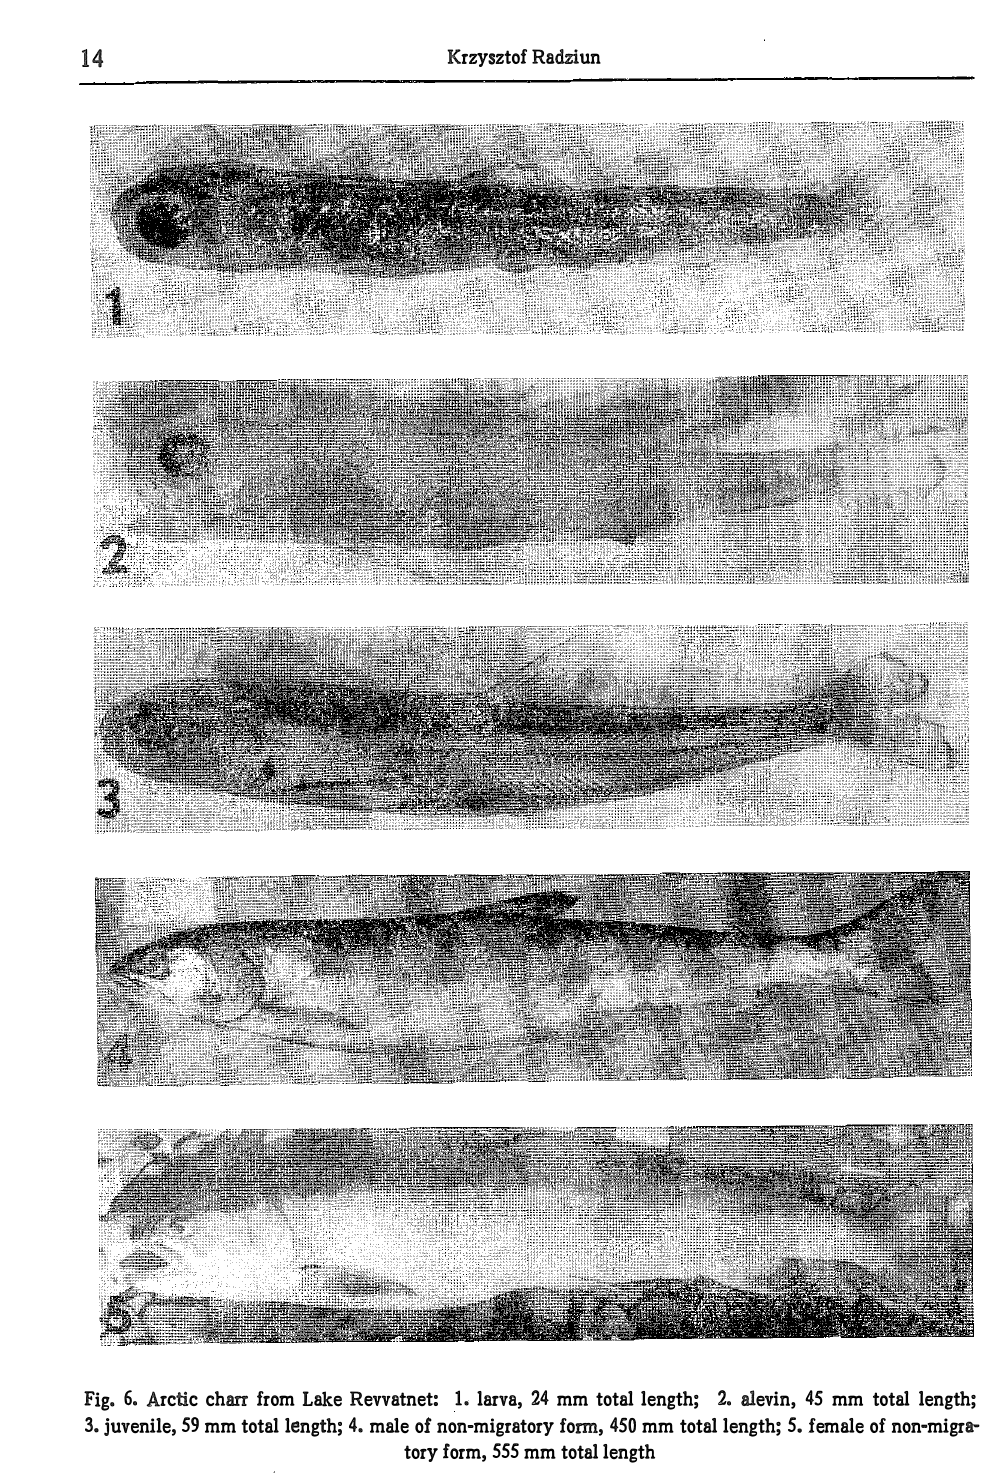
3 .juve nile, 59 m m t o ta l len gth; 4. ma le o f no n- mi gra t o r y f o rm , 4 5 0 m m t o ta l le ngt h; 5. f e ma le of non ·mig ra· t o r y f or m , 555 m m t o ta l l e n g t